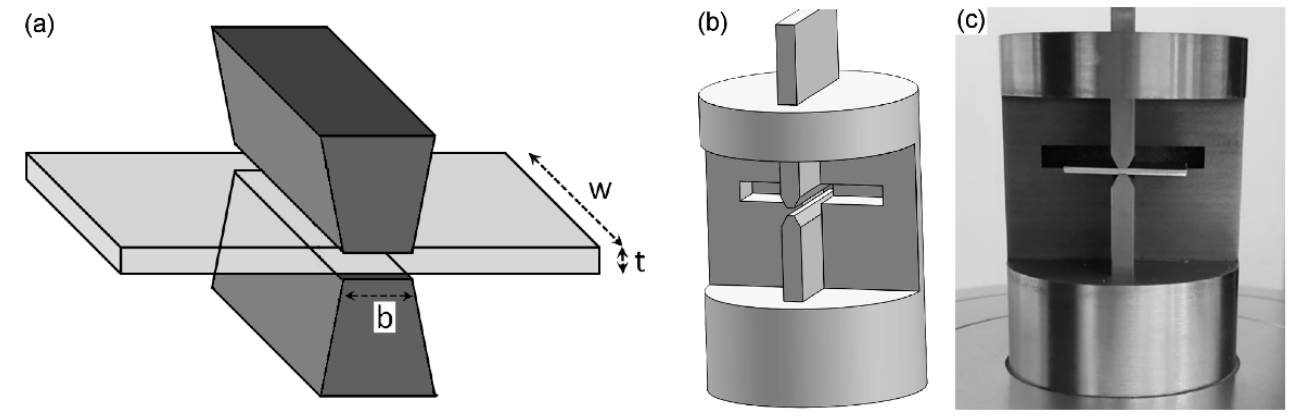
Figure 1. ( a ) Illustration of the sample and tool parameters, ( b ) design and ( c ) photo of a tool for plane strain compression test.